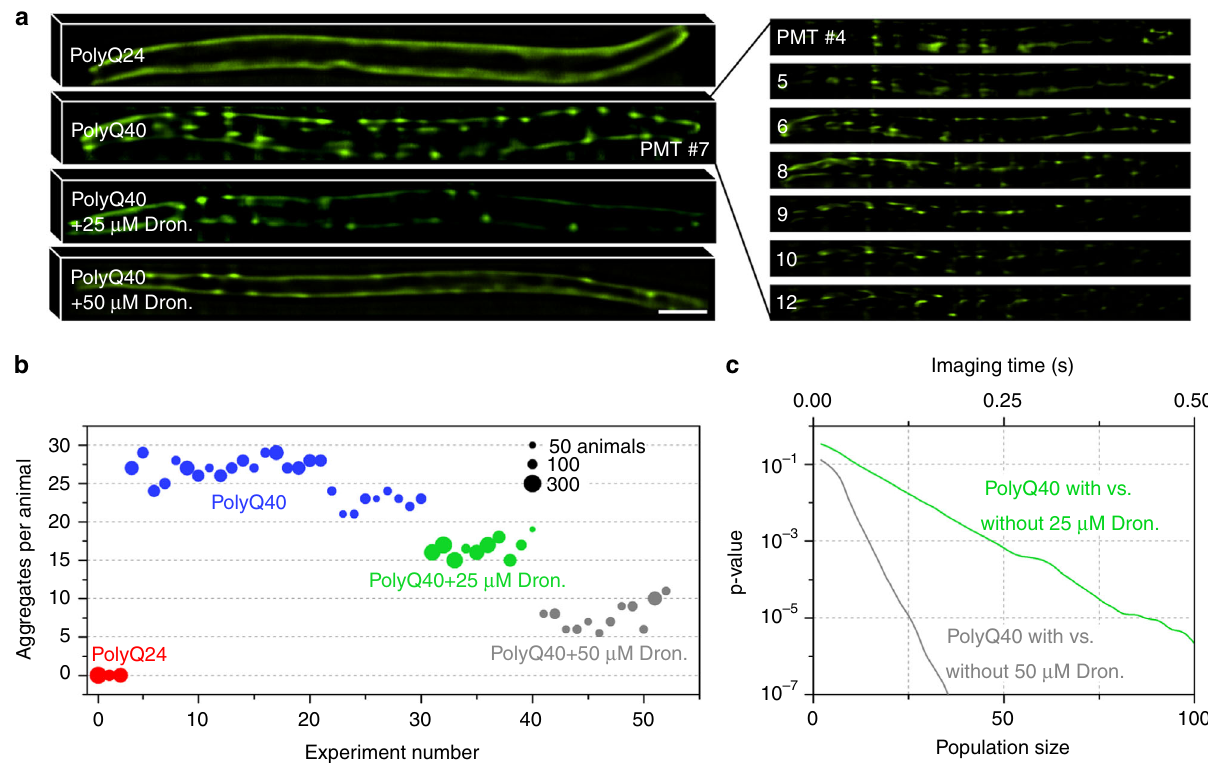
Fig. 3 LEAD microscopy results from imaging YFP-labeled, polyglutamine (polyQ) mediated aggregation model C. elegans treated with the compound dronedarone. a PolyQ24 control, polyQ40, and drug-treated polyQ40 animals imaged with our system. The images obtained from the different PMT elements for the polyQ40 animal show the necessity for the system ’ s axial sectioning capabilities. Images from single PMT elements are shown for the other animals. PolyQ24 shows diffused fl uorescence throughout the body wall muscle cells. PolyQ40 presents distinct fl uorescent aggregates in the body wall muscle cells. Treatment with dronedarone prevents the formation of aggregates, and we can detect a dose response. Scale bar = 50 µ m. b The median number of fl uorescent protein aggregates for populations of untreated and dronedarone-treated polyQ aggregation model animals, delivered through the micro fl uidic device and imaging system at ~1 m s − 1 . Each data point represents an experiment with a full population delivered through the chip. The polyQ24 control animals show no aggregates, while the untreated polyQ40 animals have 27 ± 3 aggregates per animal, and dronedarone-treated animals have 16 ± 5 and 7 ± 2 aggregates per animal for 25 μ M and 50 μ M, respectively. c The difference in the number of aggregates per animal for untreated and dronedarone-treated polyQ40 animals reaches statistically signi fi cant levels in under a quarter second, assuming 1 ms imaging time per animal and 4 ms between animals (Supplementary Fig. 6c), demonstrating the potential for high-throughput drug screening. The plot was generated by two-sample t -tests with unequal variances on equal sized subpopulations of untreated and drug-treated